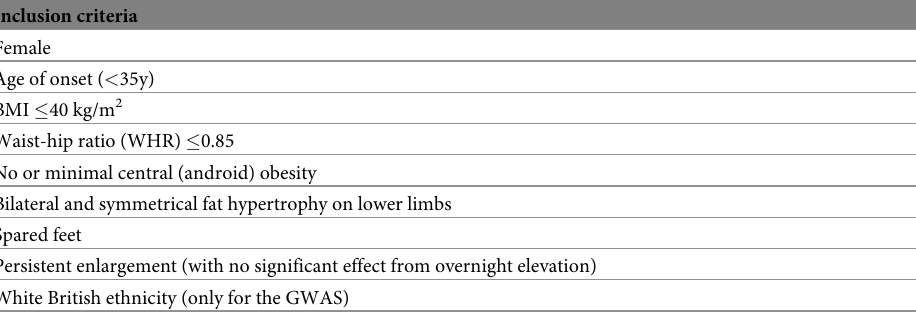
Table 1. Summary of inclusion